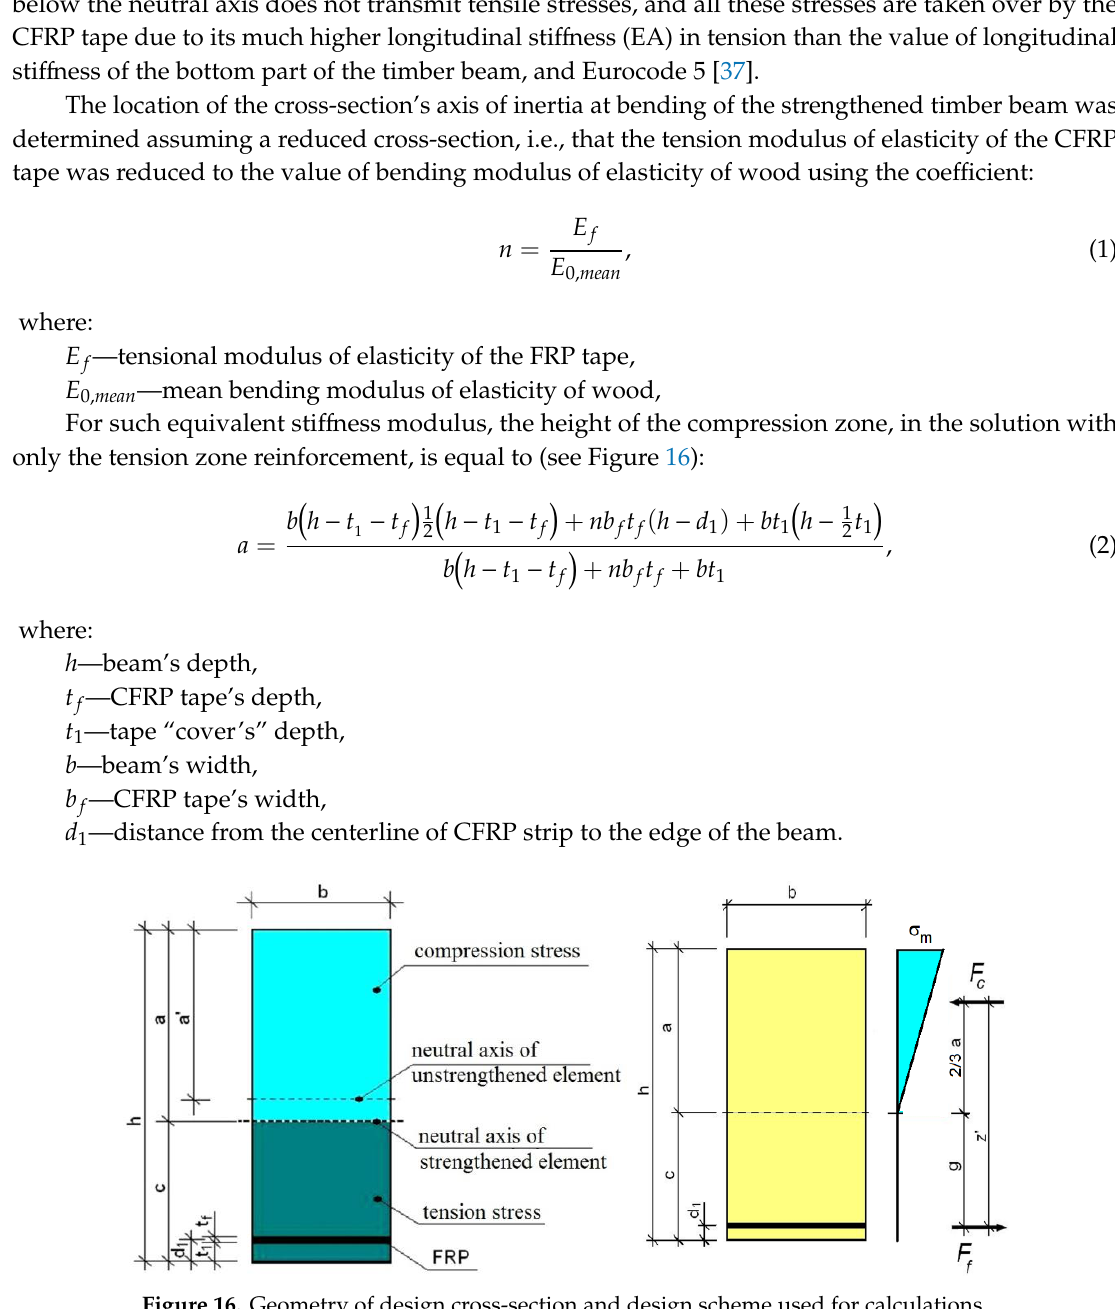
Figure 16. Geometry of design cross-section and design scheme used for calculations.